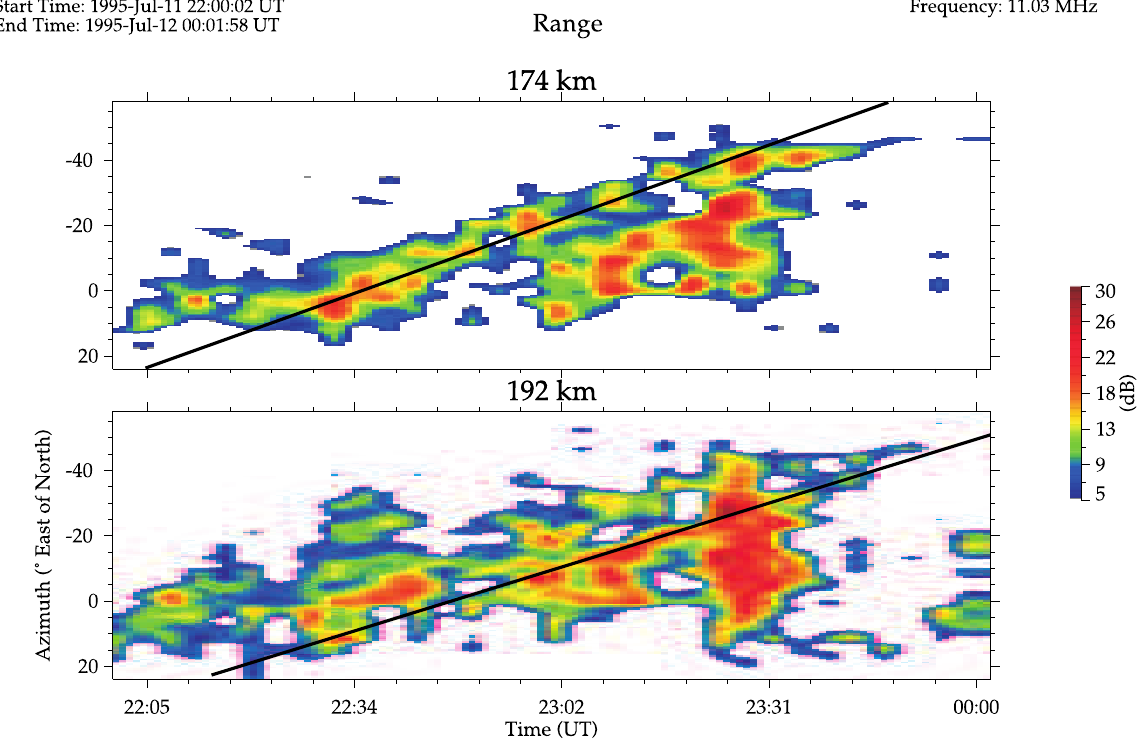
Fig. 3. Azimuth-Time-Intensity (ATI) plot from analysis of Valensole HF coherent backscatter observations. The time period corresponds to that of the ionograms shown in Fig. 2. The period of interest is from 22:30 to 23:30 UT, 11 July 1995. The striations indicated by the black lines gives an average EW drift of ∼